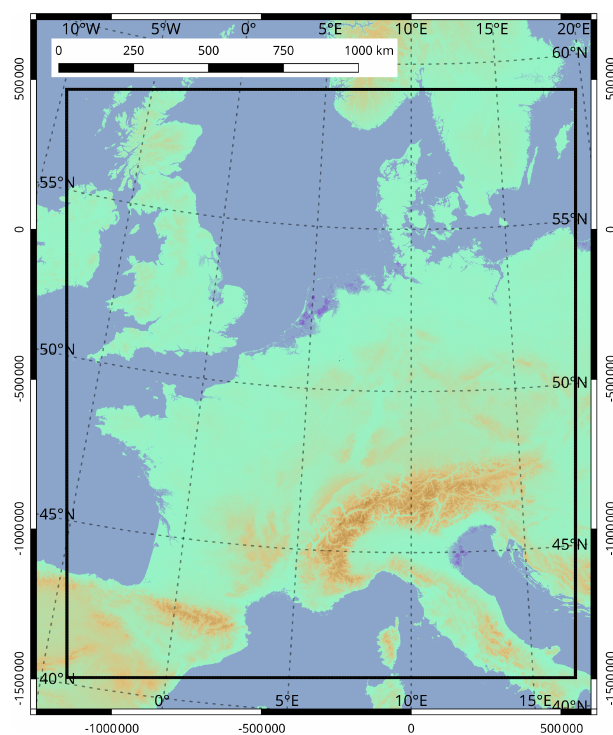
Figure 1. Inner domain of the CMAQ model (black line) along with the coordinates of the CMAQ projection (values outside the zebra